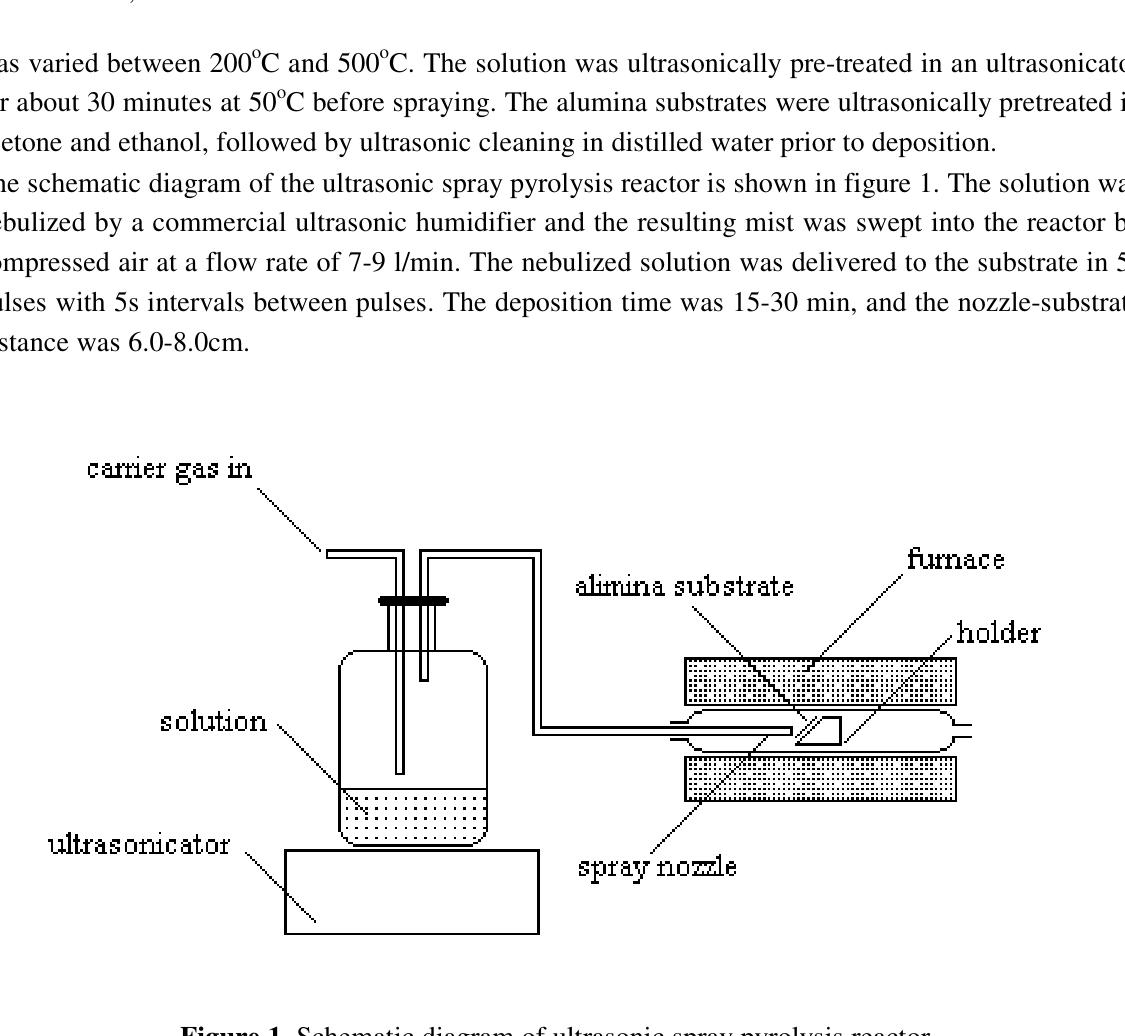
Figure 1. Schematic diagram of ultrasonic spray pyrolysis